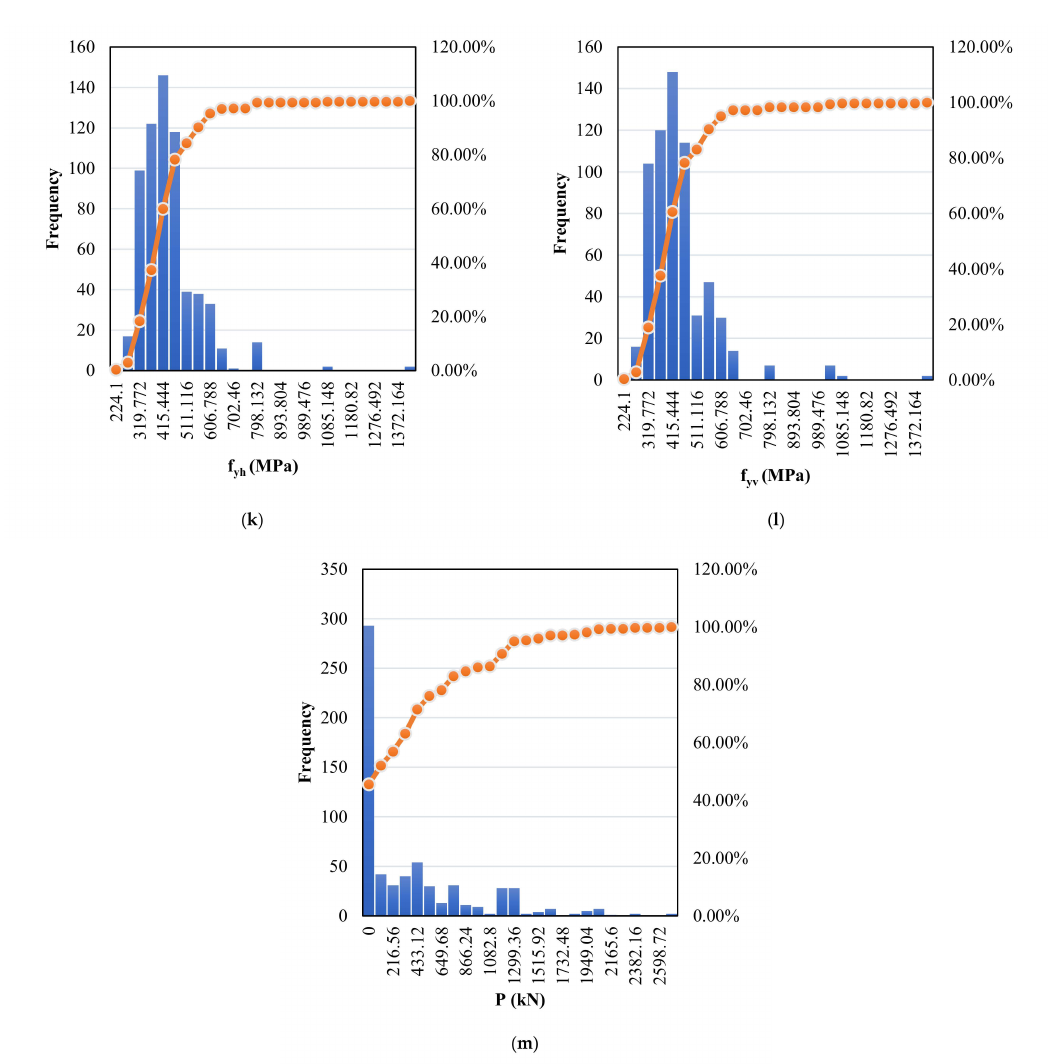
Figure 1. Ranges of dataset parameters. ( a ) Height of wall ( h w ), ( b ) Web length ( l w ), ( c )Web thickness ( t w ), ( d ) Flange thickness ( t f ), ( e )Flange elements length ( l f ), ( f ) Compressive strength of concrete ( f c (cid:48) ), ( g ) Longitudinal reinforcement ratios of the flanged element ( ρ f ), ( h ) Yield strength of longitudinal reinforcement ( f yf ), ( i ) Reinforcement ratio of wall in the horizontal direction ( ρ h ), ( j ) Reinforcement ratios of wall in vertical direction ( ρ v ), ( k ) Yield strength of the horizontal bars ( f yh ), ( l ) Yield strength of vertical bars ( f yv ), ( m ) Axial load in wall